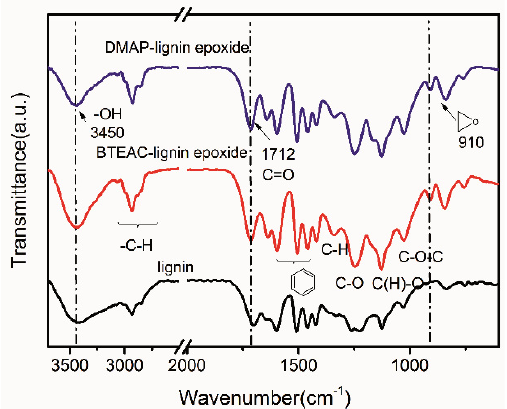
Figure 1. FTIR spectrum of the lignin, DMAP-lignin epoxide, and BTEAC-lignin